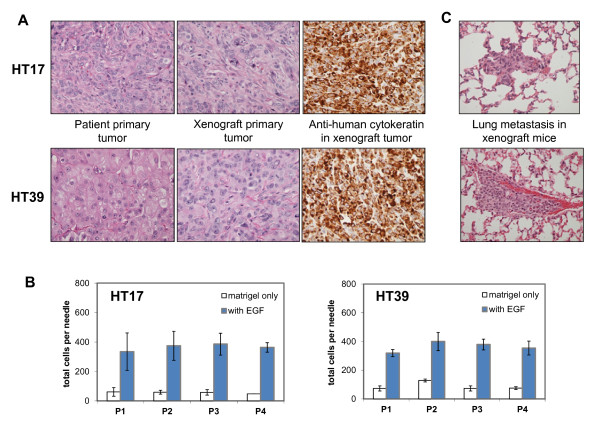
Histologic and metastatic properties of the patient-derived orthotopic breast tumor xenografts. (A) For the HT17 and HT39 patient tumors, representative images are shown here of (from left to right) primary tumor from the patient of origin (H&E), primary tumor in the xenograft (H&E), and staining of the xenograft tumor with a human-specific anti-cytokeratin antibody (immunohistochemistry, brown). Magnification ×40. (B) In vivo invasion assay for HT17 and HT39 xenograft tumors to an EGF gradient, passages 1 through 4 (P1-P4). Invasion to a gradient of serum (FBS) showed similar results. The number of migratory cells remains similar over passages (P = 0.47 for HT17, P = 0.82 for HT39, by one-way ANOVA). Results are plotted as average number of cells per microneedle. Error bars: SEM, n ≥ 5 mice. (C) Representative images of spontaneous lung metastasis of the xenograft orthotopic tumors (H&E). Magnification ×40.